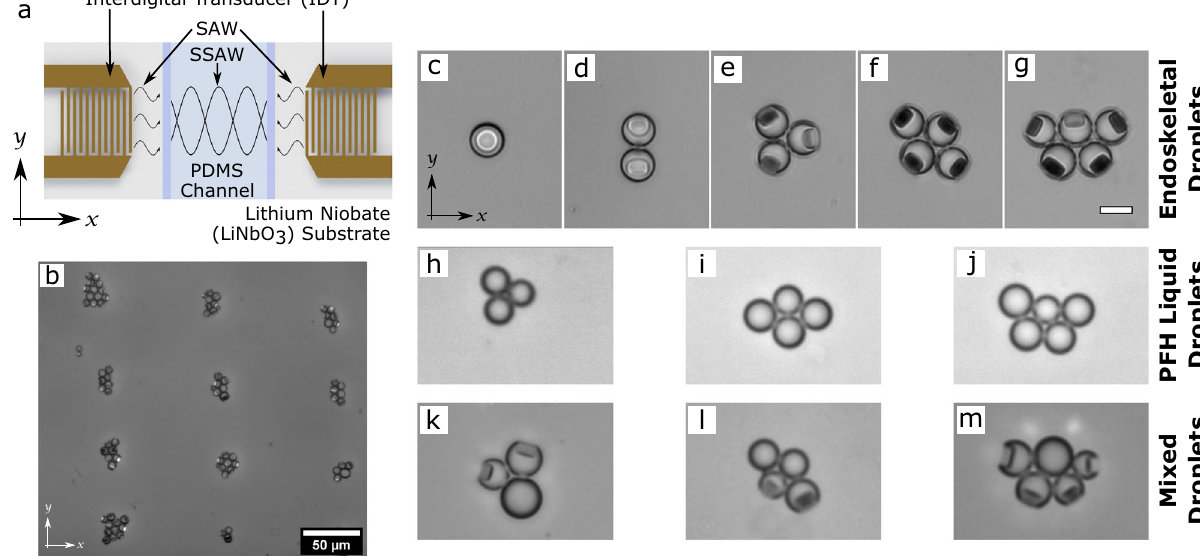
Fig. 2 Endoskeletal Droplet Patterning under standing SAW. a Schematic of the SAW IDT devices used for patterning experiments. b Clustering behavior of endoskeletal droplets under 1D standing SAW. Scale bar, 50 μ m. Zoomed in images of the droplet clusters under 1D standing SAW with 1 droplet ( c ), 2 droplets ( d ), 3 droplets ( e ), 4 droplets ( f ), 5 droplets ( g ). Note that the disk orientations are different for smaller clusters ( c and d ) compared to larger clusters ( e – g ). h , i , j Liquid PFH droplet show similar clustering behavior as endoskeletal droplets. k , l , m Clusters containing mixture of liquid only PFH droplets and endoskeletal droplets. Note that the clustering phenomenon is the same for all three types of droplets clusters and the disk orientations are not affected by the absence of other disks as well. Scale bar for all individual cluster images, 10 μ